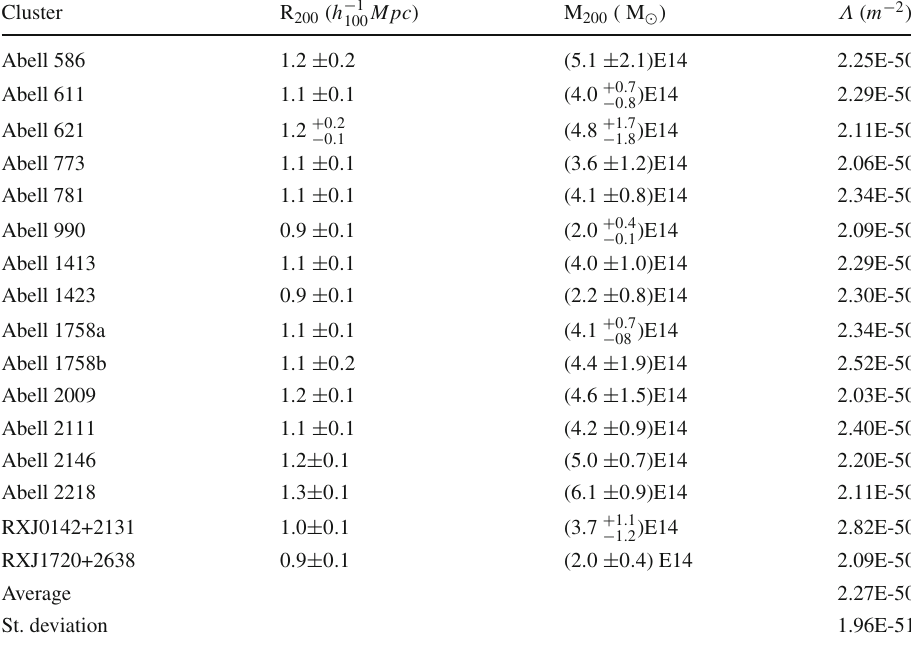
Table 8 LoCuSS Clusters